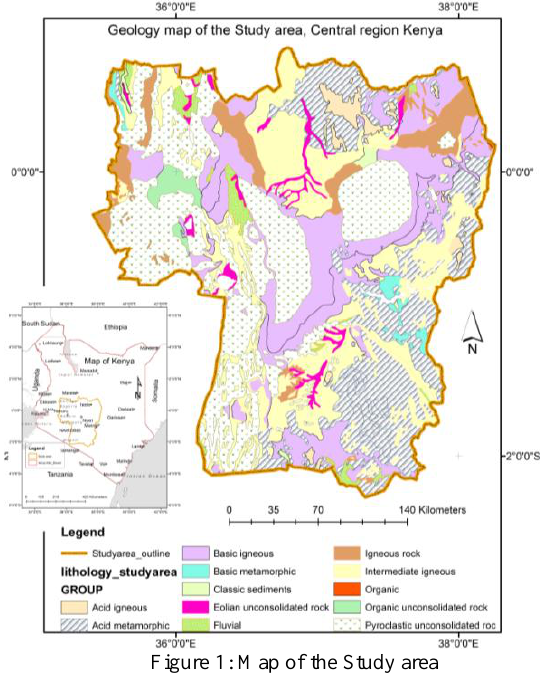
Figure 1: Map of the Study area